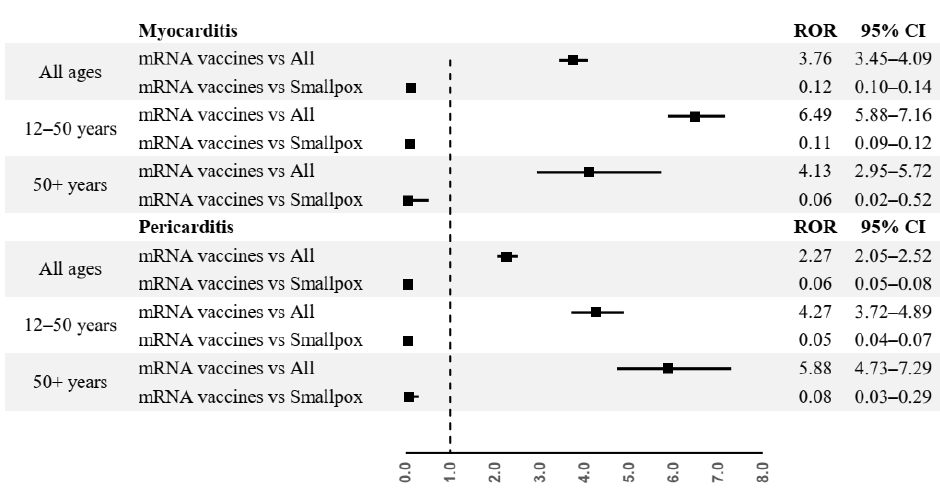
Figure 6. Disproportionality